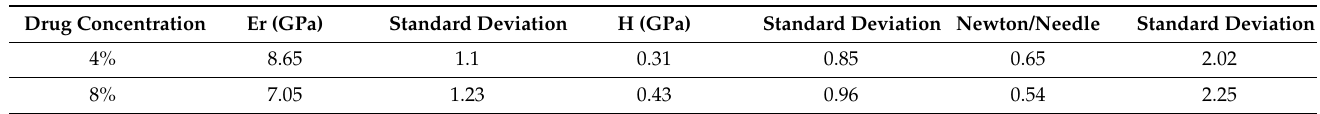
Table 1. Mechanical properties of amphotericin-B-loade d Gantrez™ polymer from nanoindentation and ElectroForce ® mechanical testing.